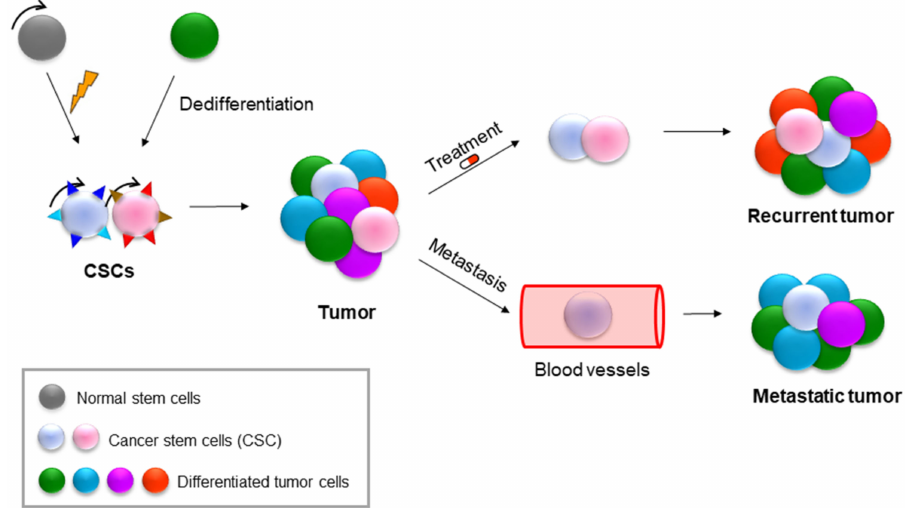
Figure 4. Brief scheme of CSC contribution to recurrence and